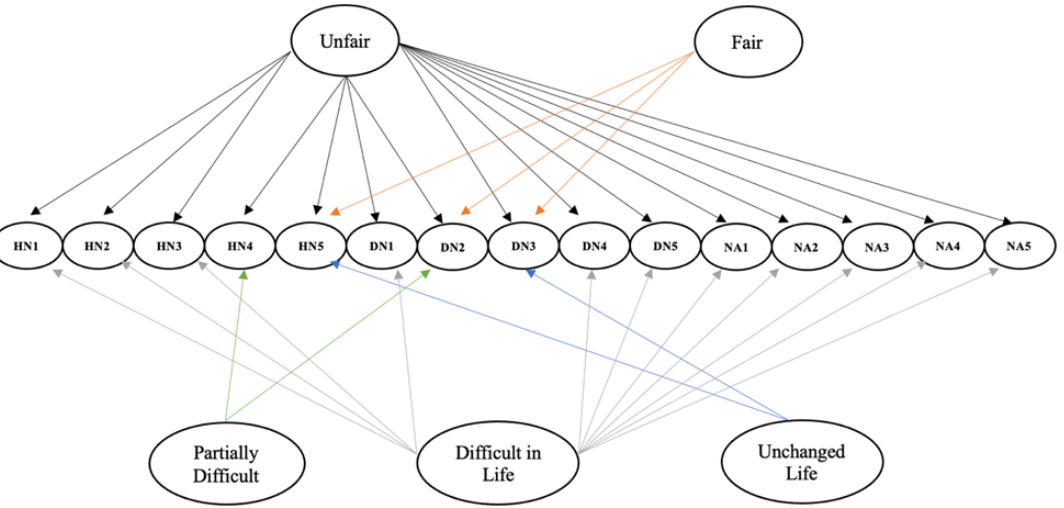
Figure 3. Household responses to policy implementation and post-acquisition livelihood in Hanoi